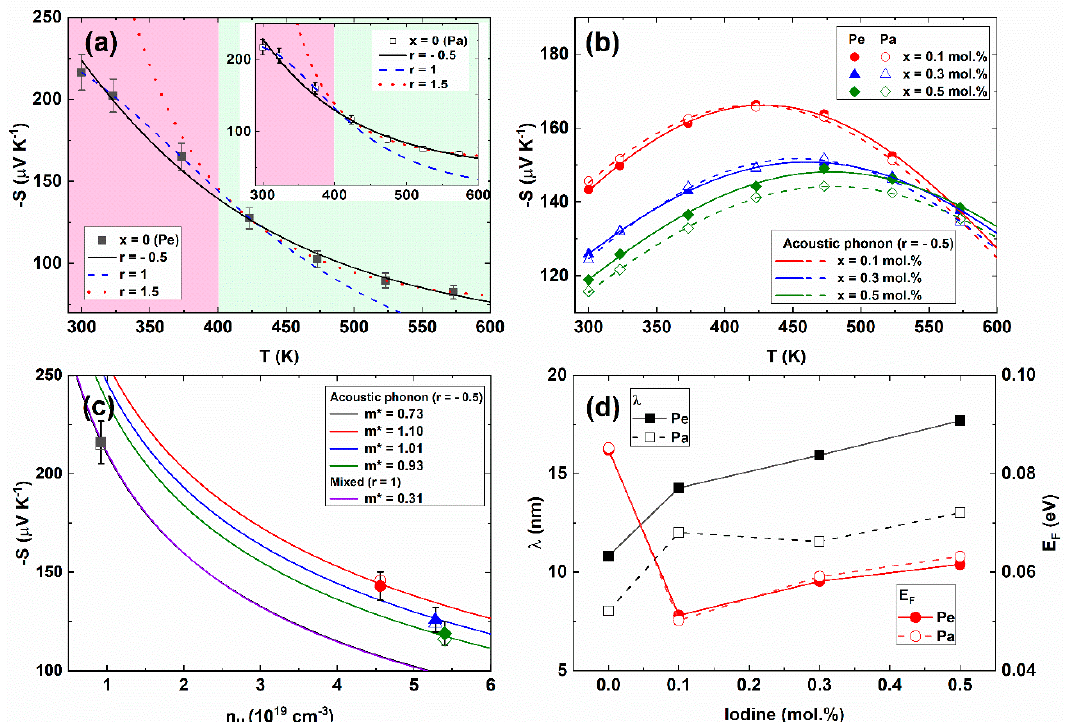
Figure 3. Temperature-dependent Seebeck coefficient S(T) of the parent compound (x = 0.0) with the mixed, ionization, and acoustic scattering mechanism (lines) (Inset is for the Pa-direction) ( a ) and for the Bi 2 Te 2.85 Se 0.15 I x (x = 0.1, 0.3, 0.5 mol.%) compounds; ( b ) Seebeck coefficient S as a function of Hall carrier concentration n H for various effective masses and scattering exponents; ( c ) The carrier mean free path λ (left axis, black squares) and the Fermi energy E F (right axis, red circles) ( d ) as a function of I-doping concentration at 300 K for the Pe-direction (closed symbol, solid line) and Pa-direction (open symbol, dashed line).